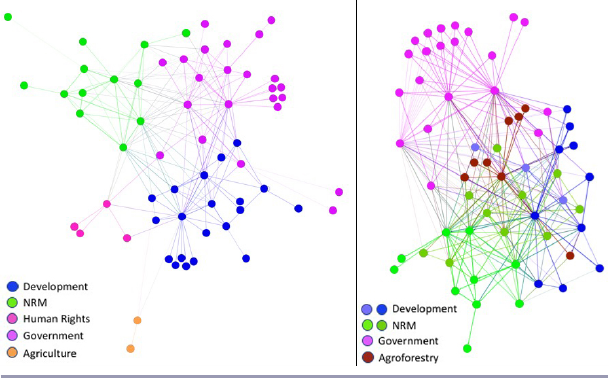
Fig. 2. Cooperation Network for Northern Plains landscape (Left) and the Eastern Plains (Right). Nodes are colored by modularity class (cluster group). In EP, similar shades are used to distinguish nodes identified as seperate clusters but with similar characteristics. The graphs are displayed using Force Atlas layout algorithm. Nodes with high indegrees are located in the center of the